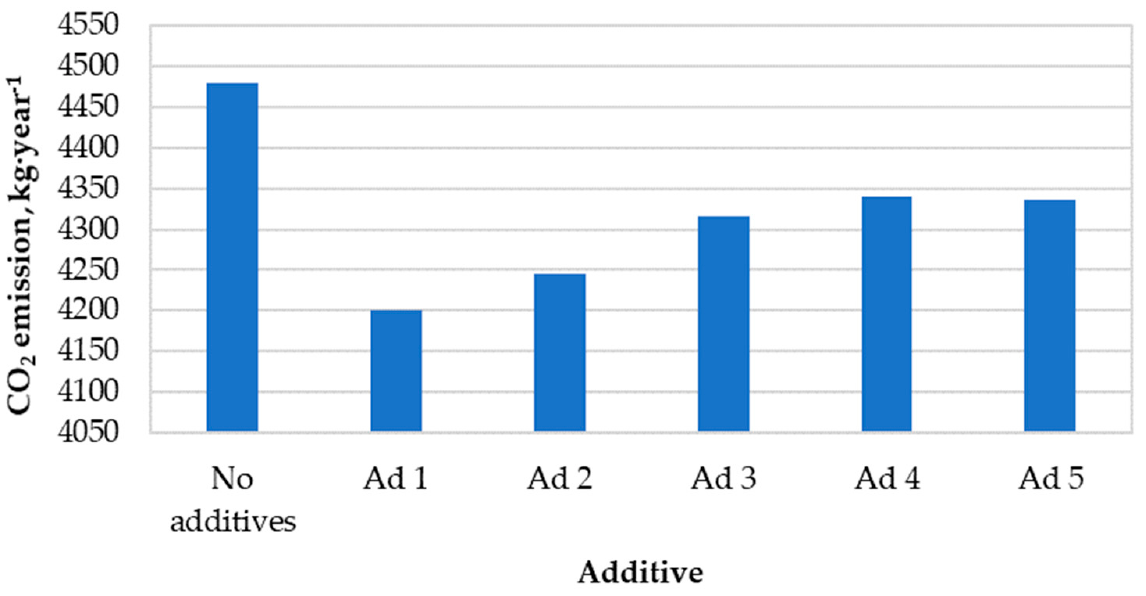
Figure 6. Annual amount of carbon dioxide emissions into the atmosphere.